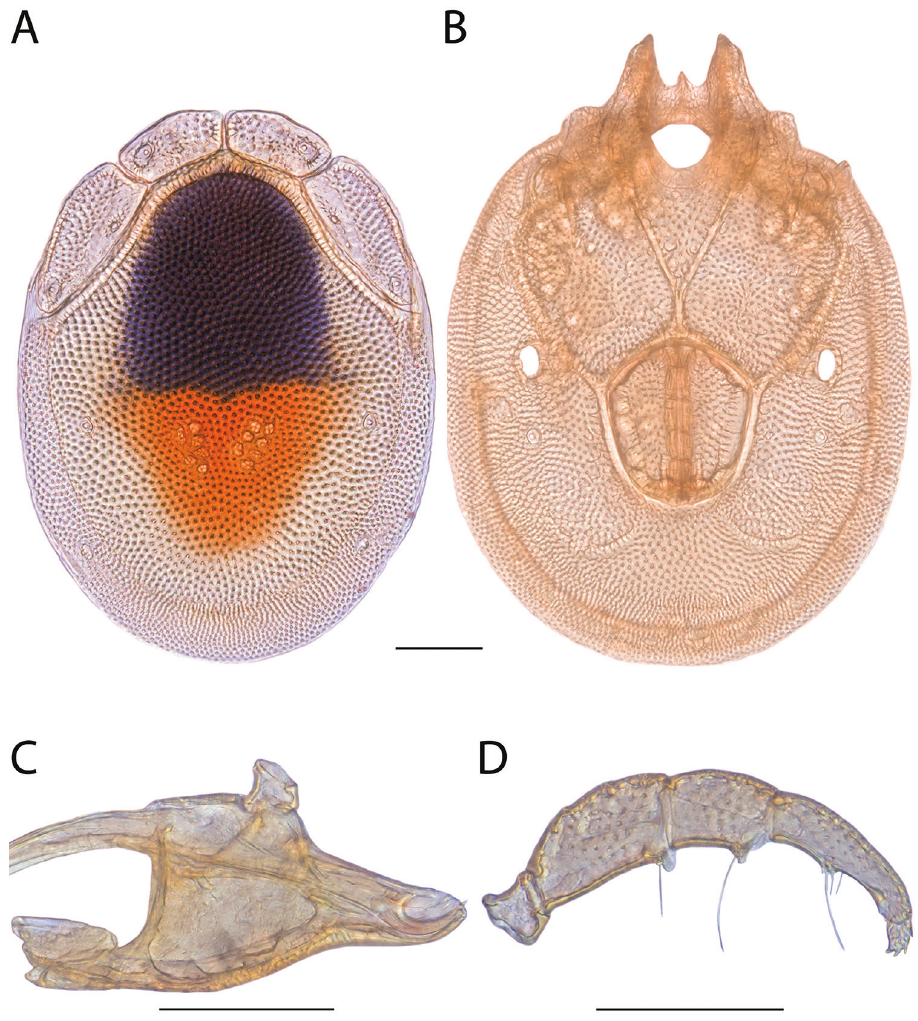
Figure 265. Torrenticola unimaculata sp. n. female: A dorsal plates B venter (legs removed) C subcapitulum D pedipalp (setae not accurately depicted). Scale = 100